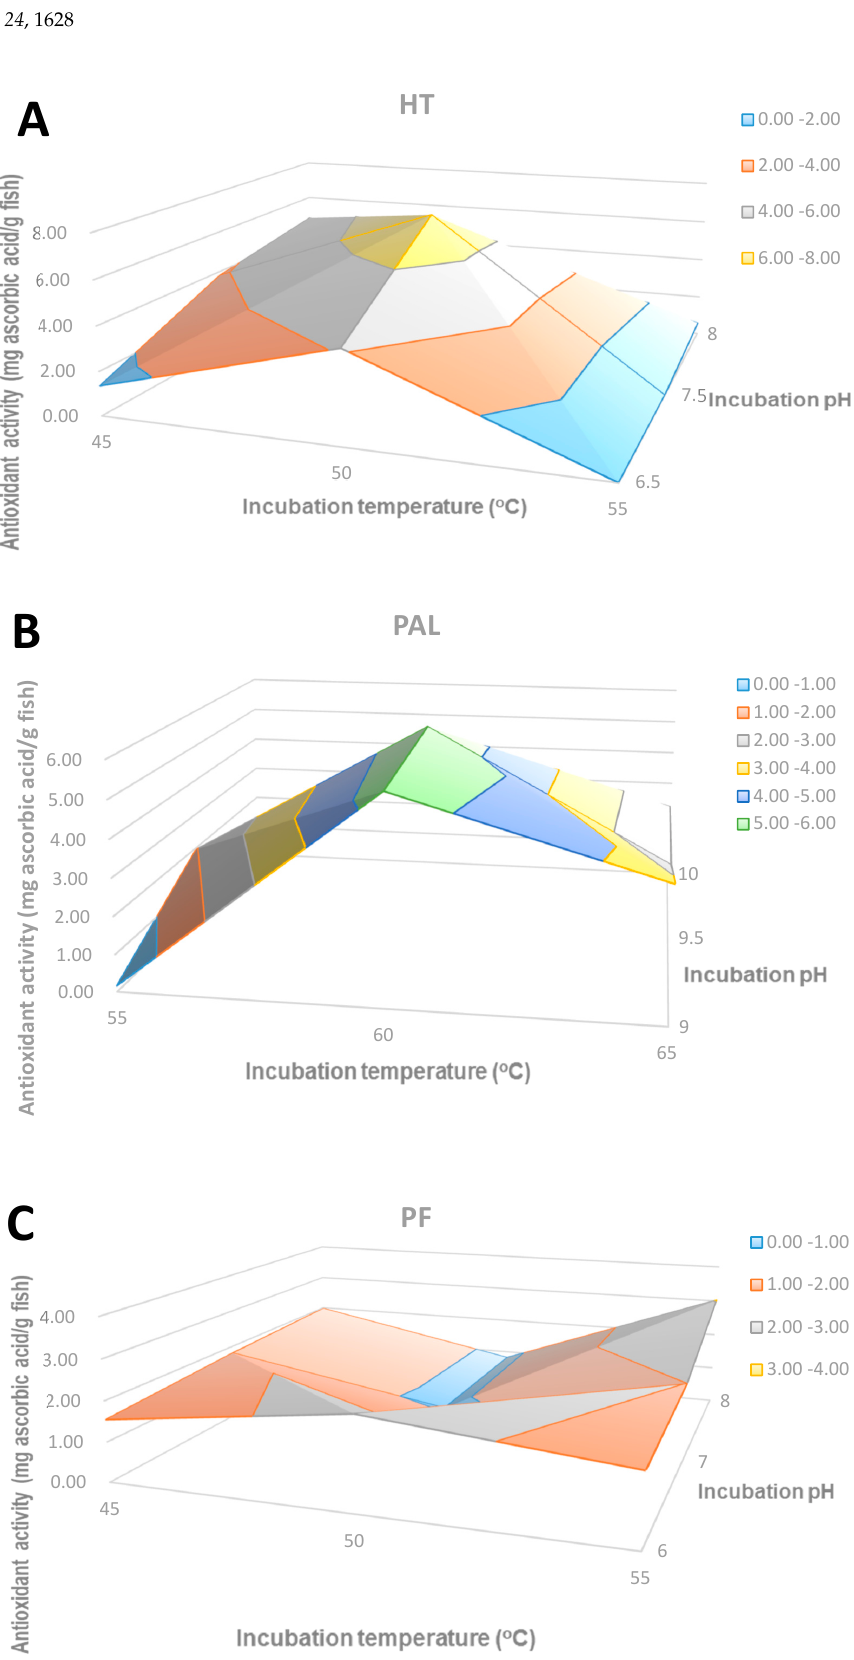
Figure 3. The antioxidant activity of hydrolysates by the FRAP method: ( A ) HT hydrolysates; ( B ) PAL hydrolysates; ( C ) PF